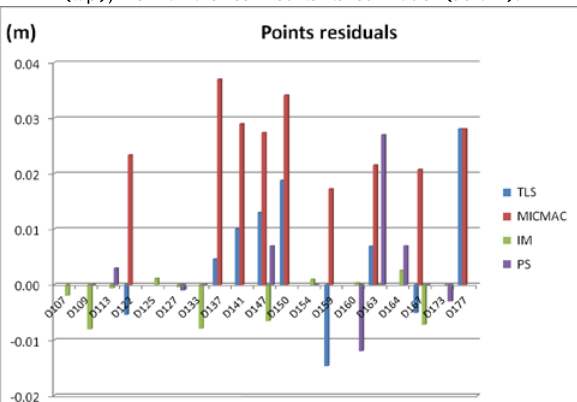
Figure 6. Diagram of the achieved results derived from comparison of several points coordinates measured by topographic method and by different matching process or TLS